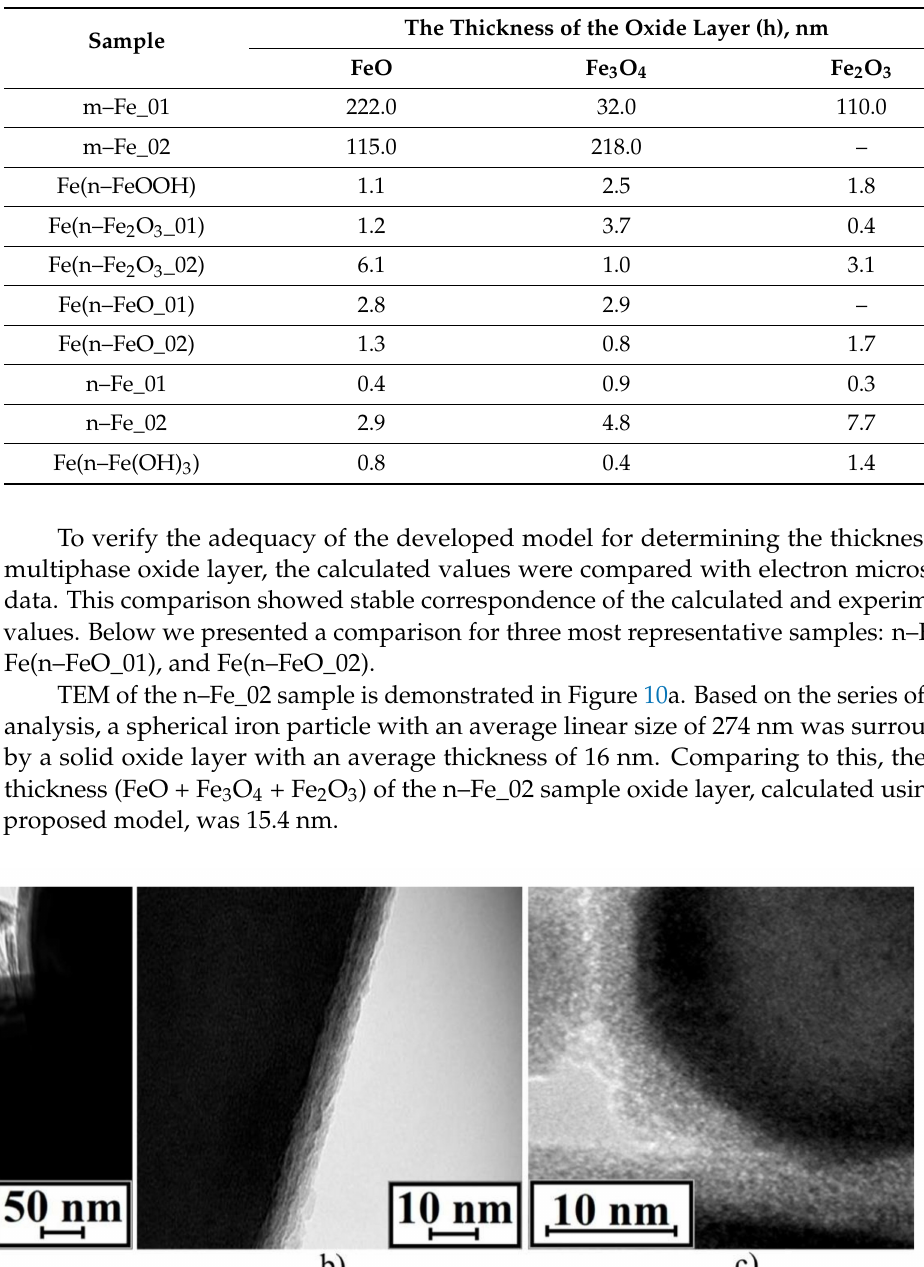
Table 3. Results of the multiphase oxide layer thickness calculations.